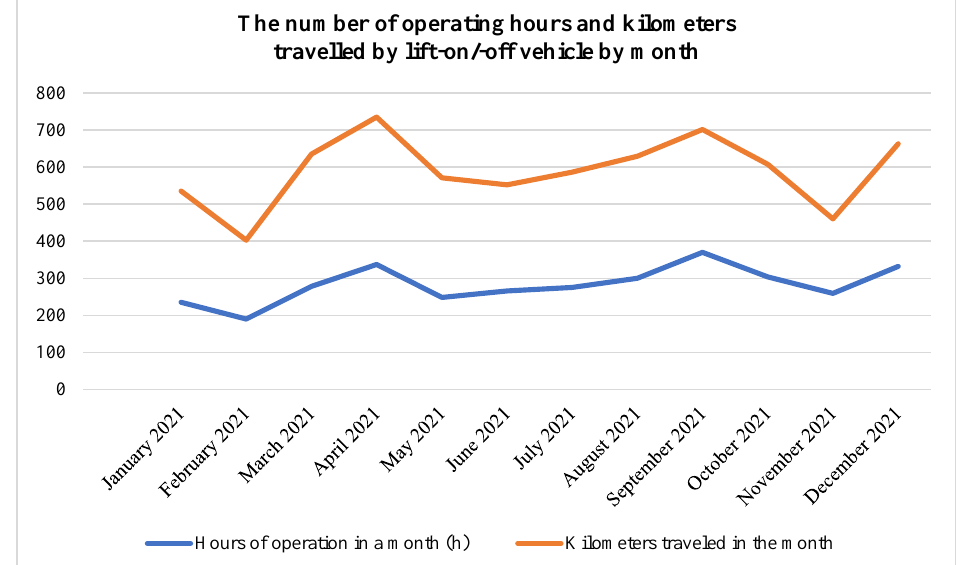
Figure 2. The number of operating hours and kilometers travelled of a container lift-on/-off vehicle by month.